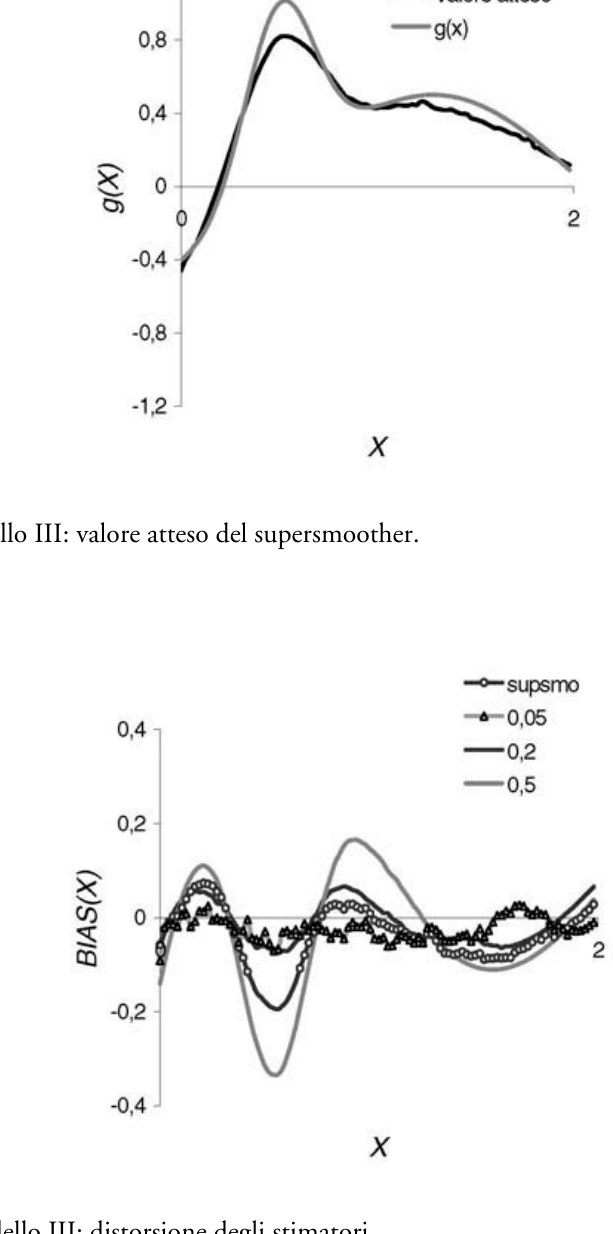
Figura 10 – Modello III: distorsione degli